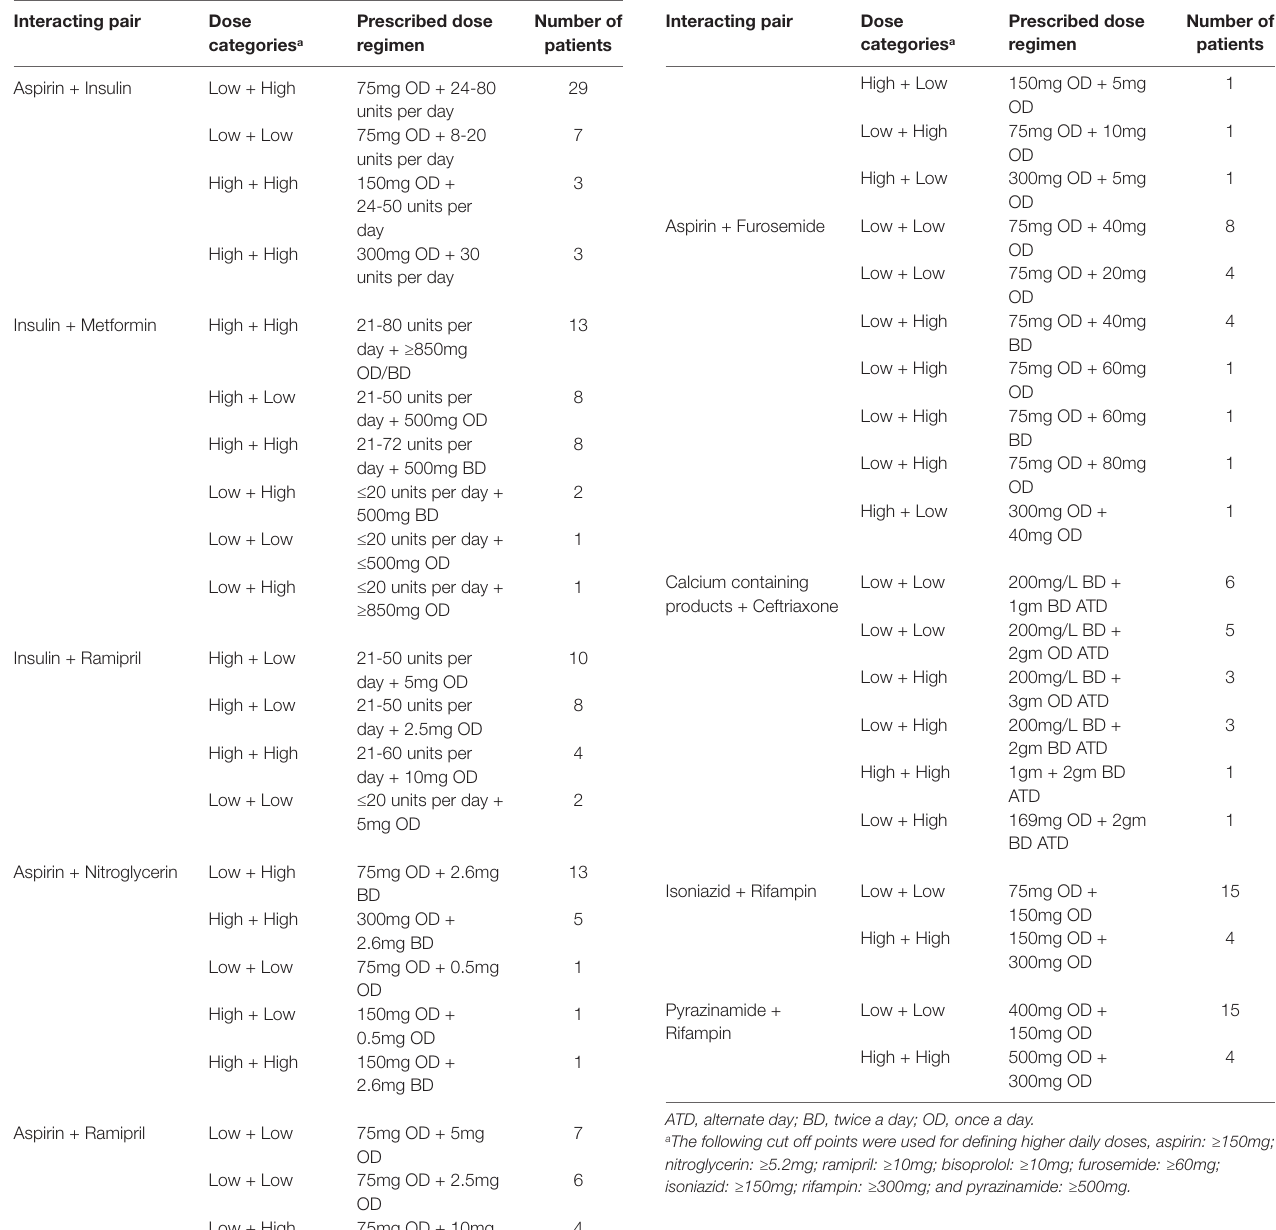
TABLE 3 | Prescribed dose regimen of the interacting